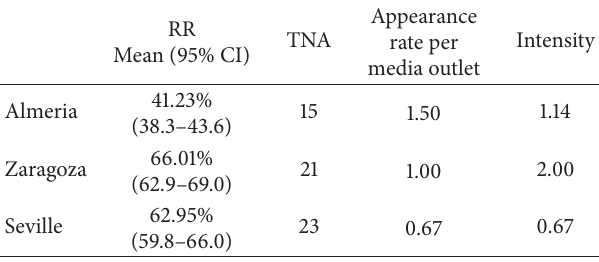
Figure 2: Response rate broken down by time of call, sex, and age.